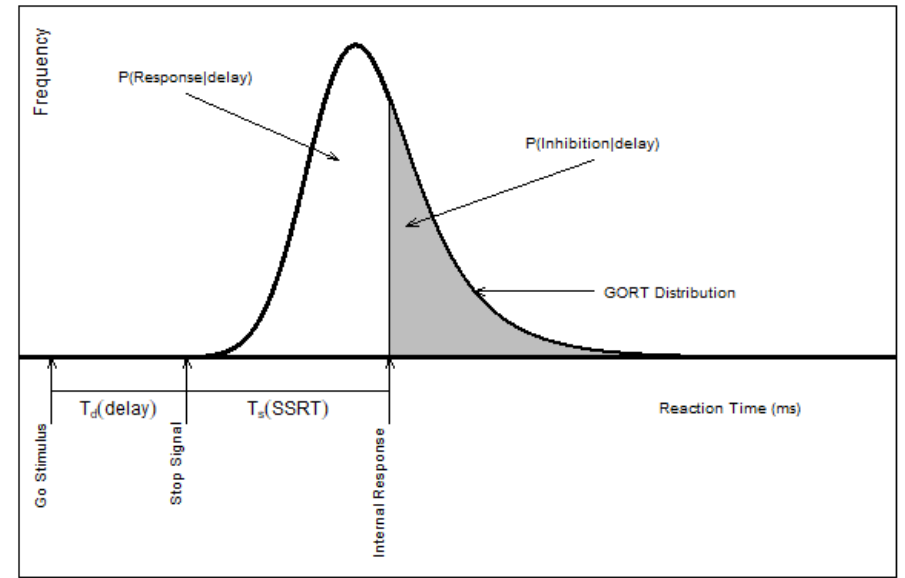
Figure 2. The independent horse race model: SSD = T d ; SSRT = T s (Logan, 1994 [1]-modified, permission is